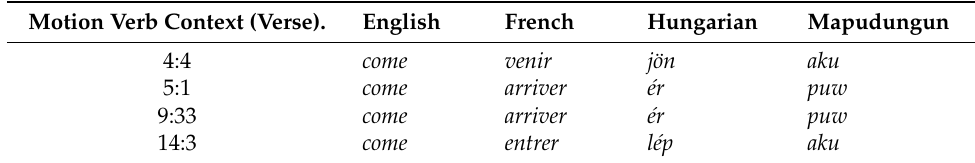
Table 3. Sample dataset from Wälchli and Cysouw (2012).